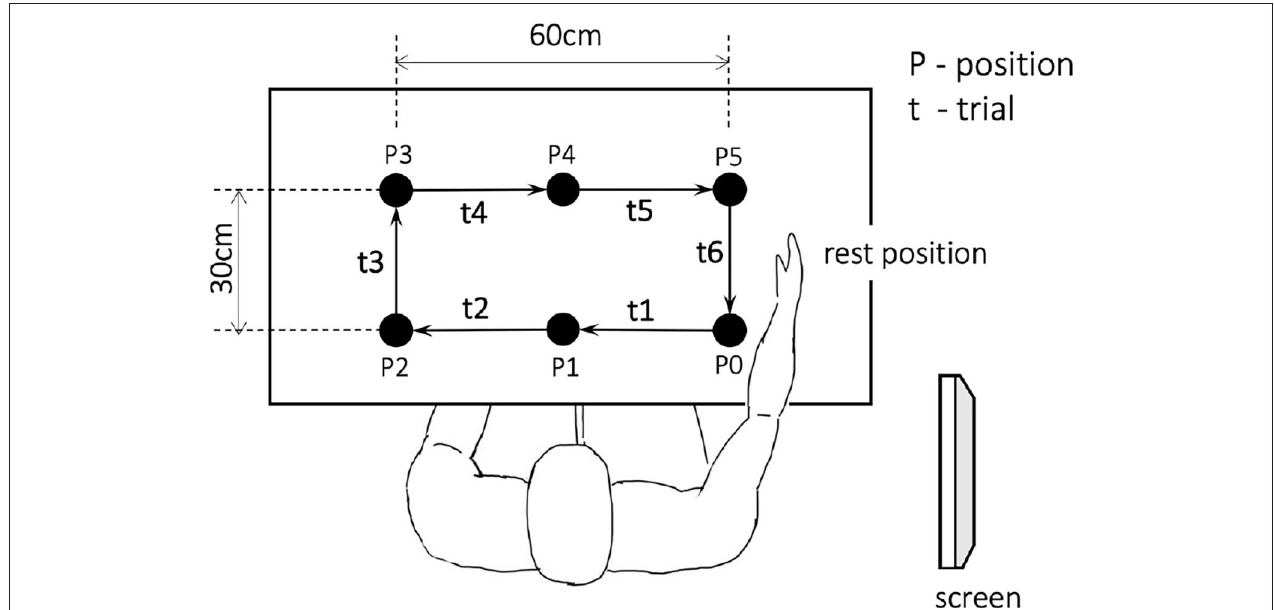
FIGURE 3 | Vertical view of the experimental setup.